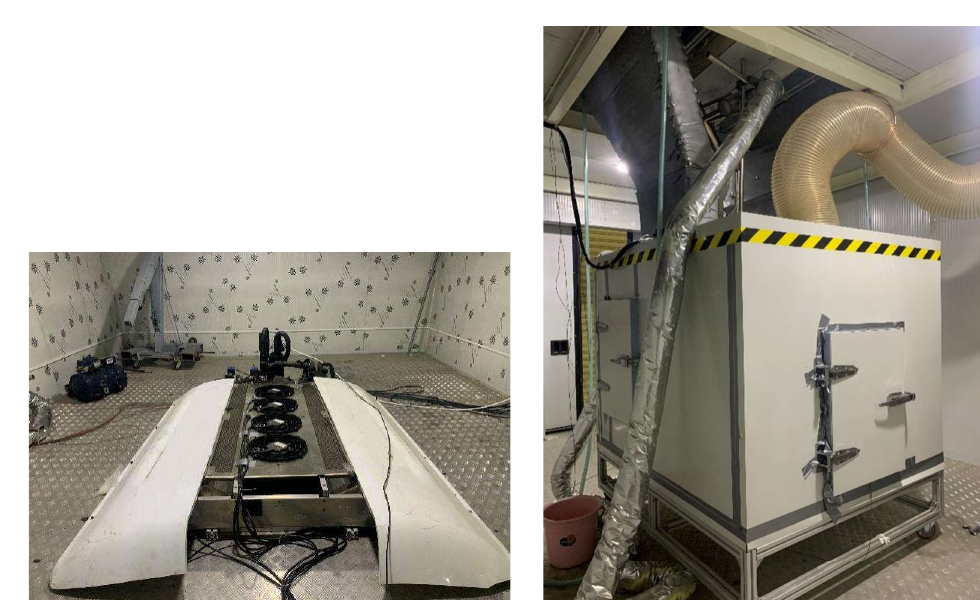
Figure 2. Photos of the transcritical CO 2 electric bus air conditioning system rig. Table 2. The actual charge and corresponding normalized